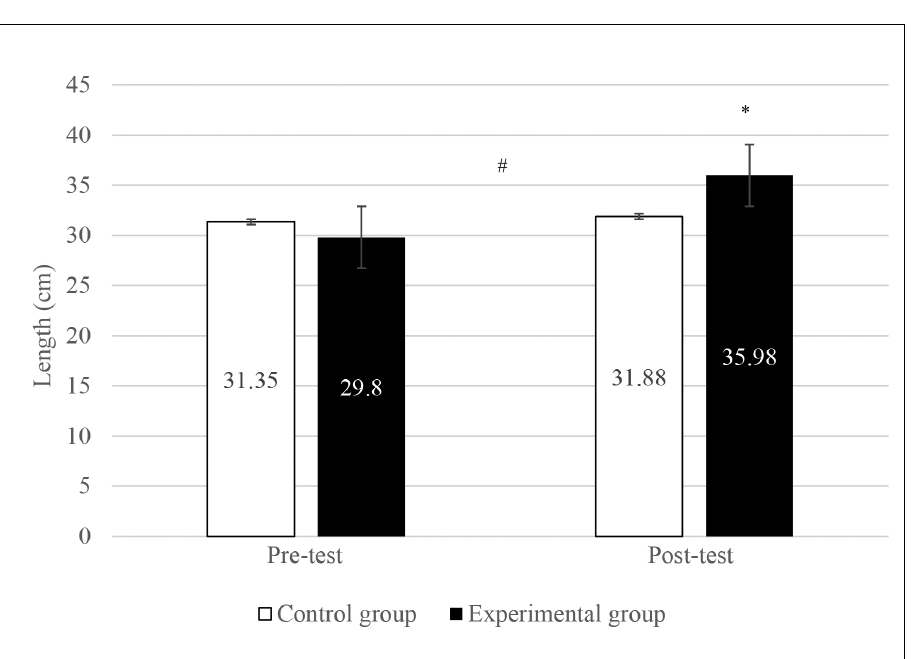
Figure 10. Flexibility test results of experimental and control